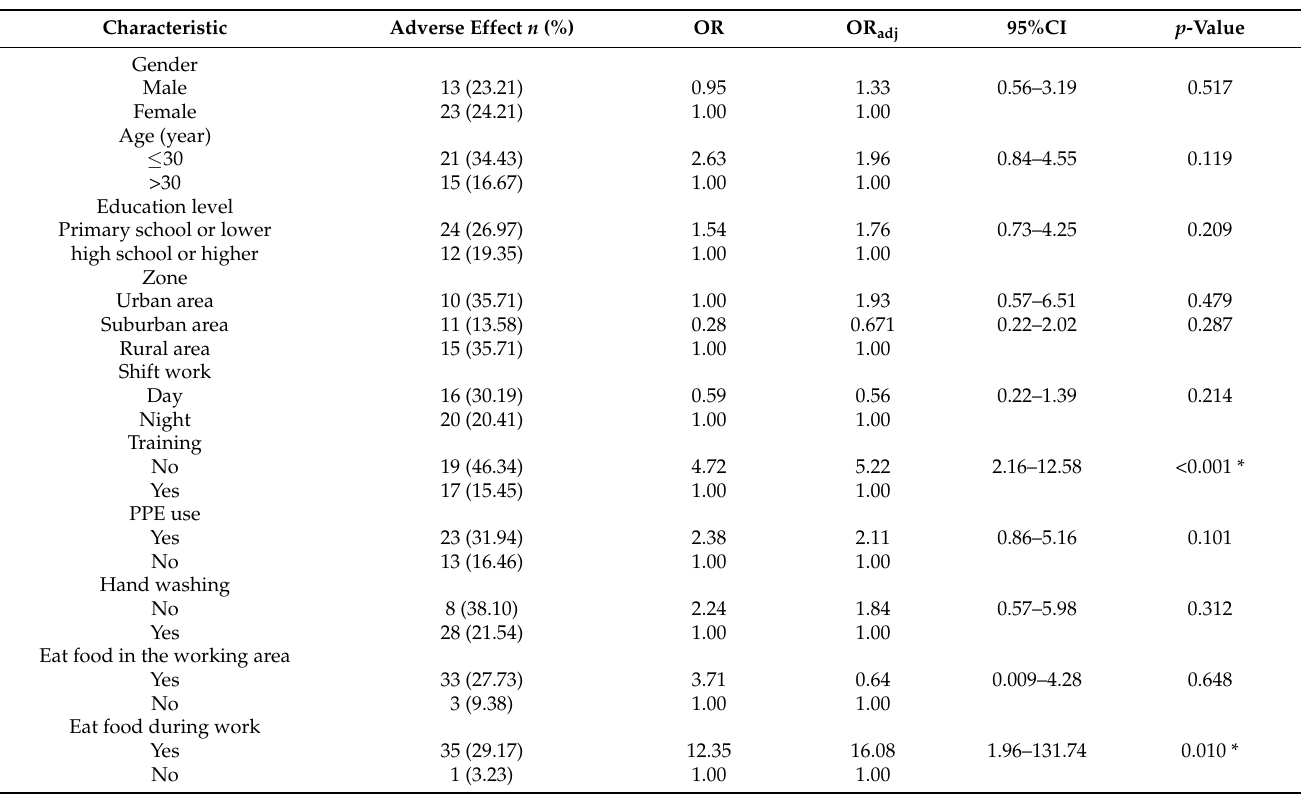
Table 3. Multiple logistic regression analysis of the potential risk factors of moderate and high levels of adverse health effects among gasoline station workers ( n =